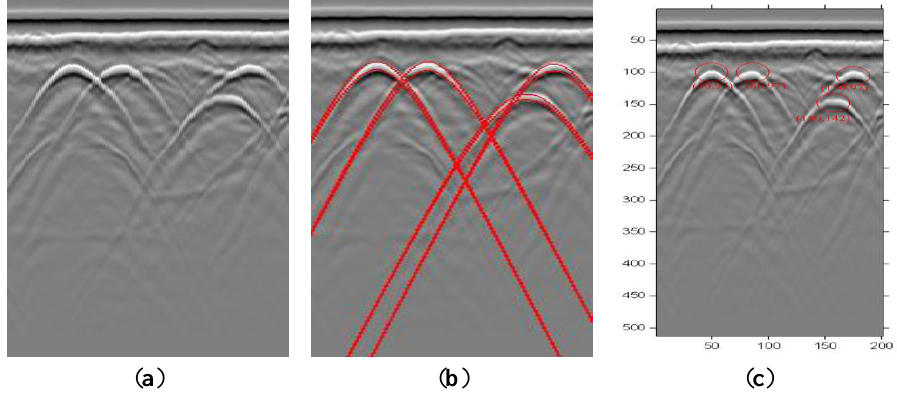
Figure 8. Example of test metal point targets data. ( a ) GPR image; ( b ) Processed result with detected patterns. The detected hyperbola is the red color line; ( c ) The position estimation results of the real point data.